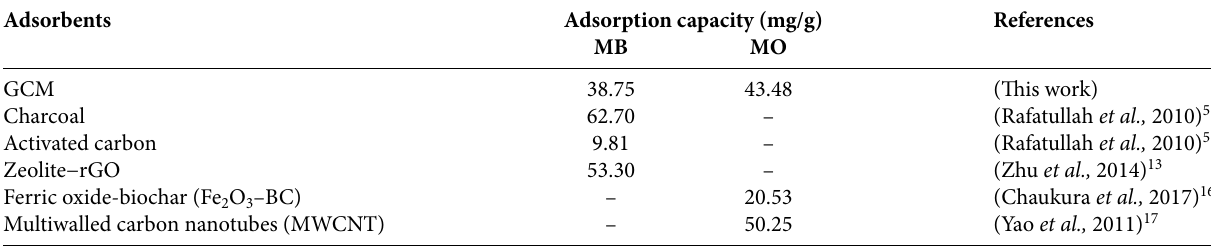
Table 2. Comparison of GCM adsorption capacity with previous reported activated carbons and graphene materials.